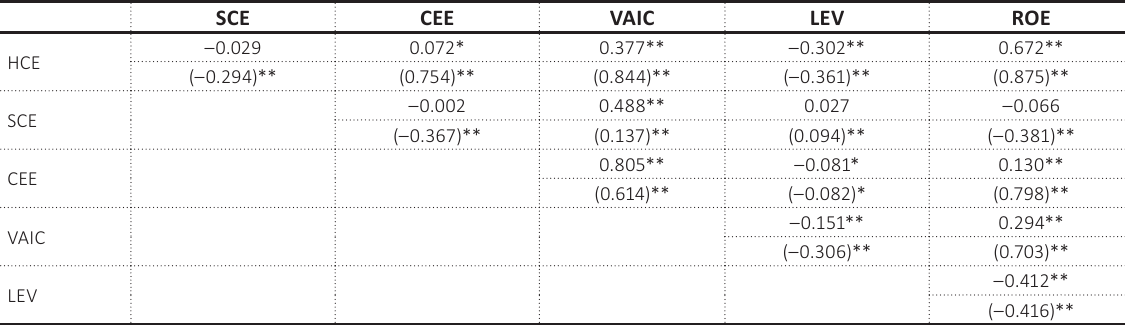
Table 2. Pearson (Spearman) correlation